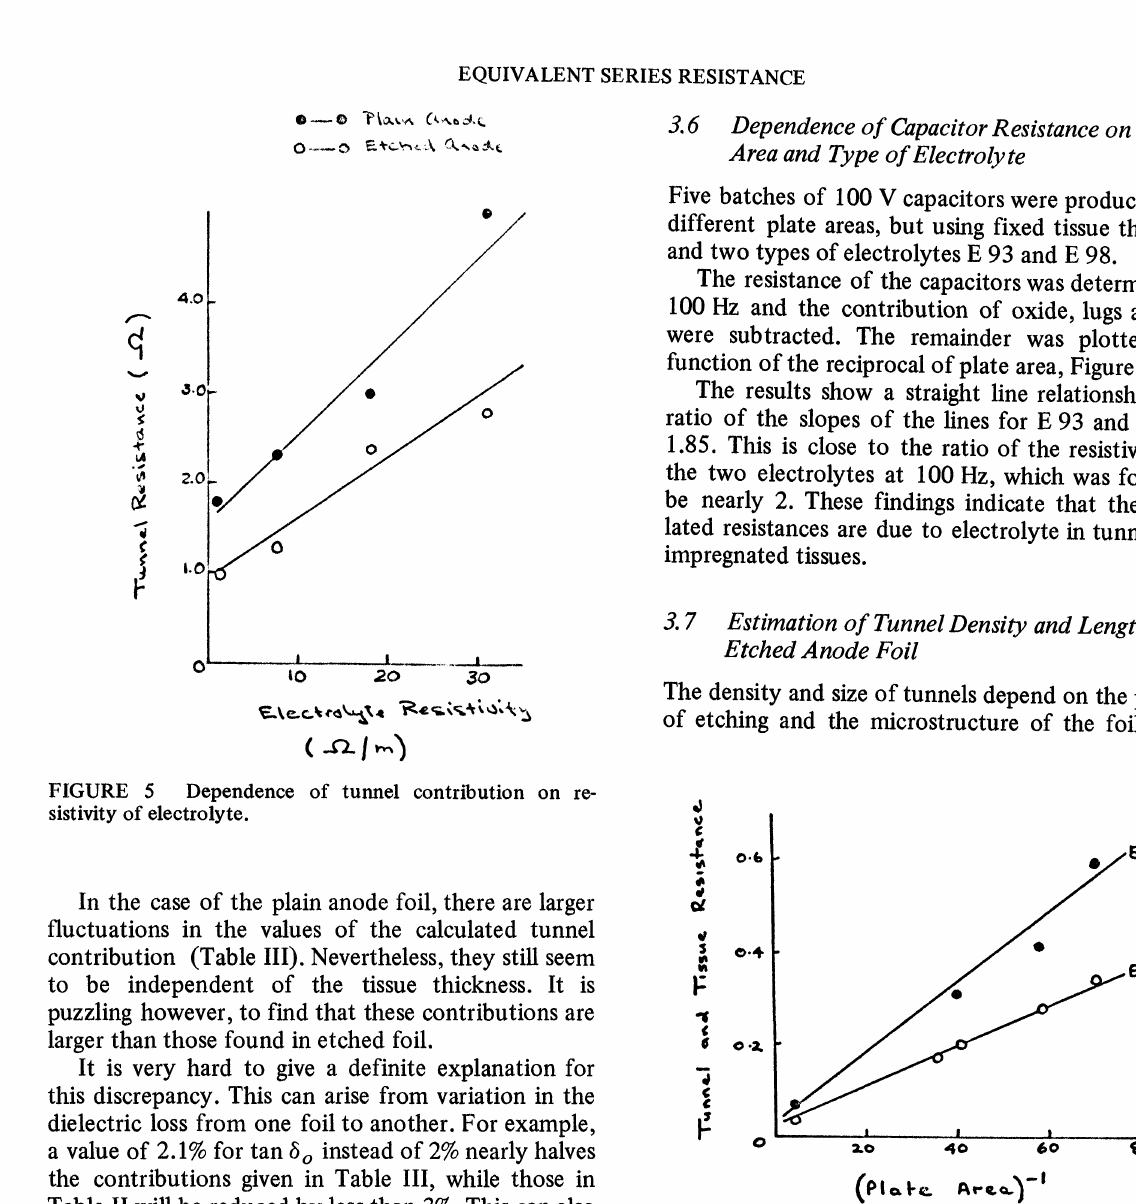
Tunnel contribution for tissues thickness